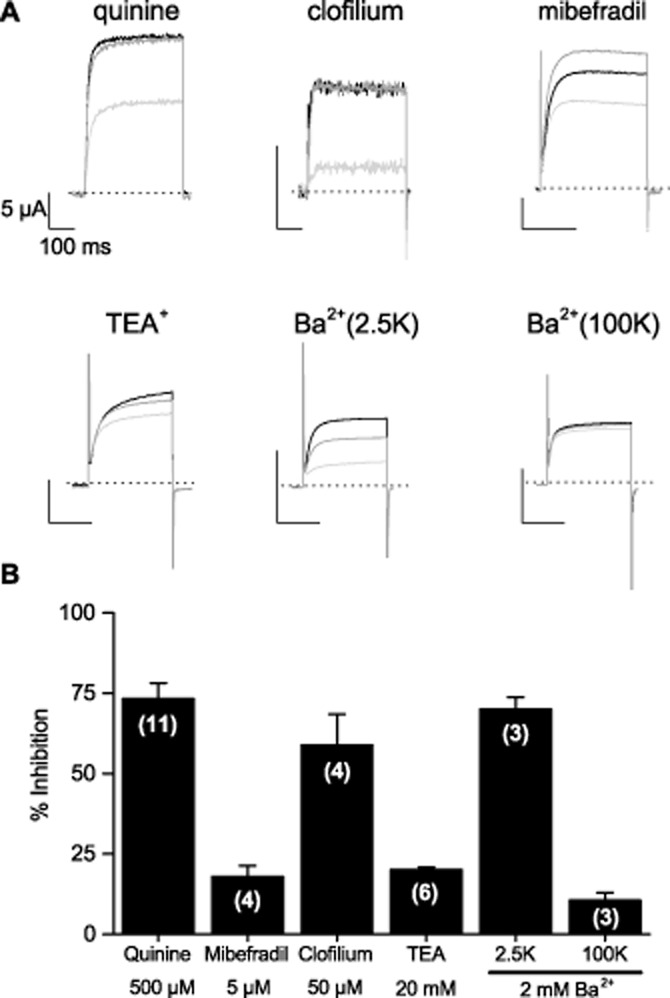
Block of mSlo3 currents by inhibitors of KSper. Oocytes were held at −80 mV and depolarizing pulses to +100 mV were applied. (A) Representative traces with each drug or condition as indicated: black trace, control currents recorded prior to drug application; light grey trace, current in the presence of the inhibitor; dark grey trace, current after washing out the inhibitor for at least 10 min. The dashed line represents the zero-current level and scale bars represent equivalent current amplitudes and timescales. The effects of Ba2+ were measured in both the standard solution containing 2.5 mM K+ (2.5K) and with a high 100 mM K+ solution (100K). (B) Mean percentage inhibition for each drug or condition as indicated (n values indicated in parentheses in the bars).